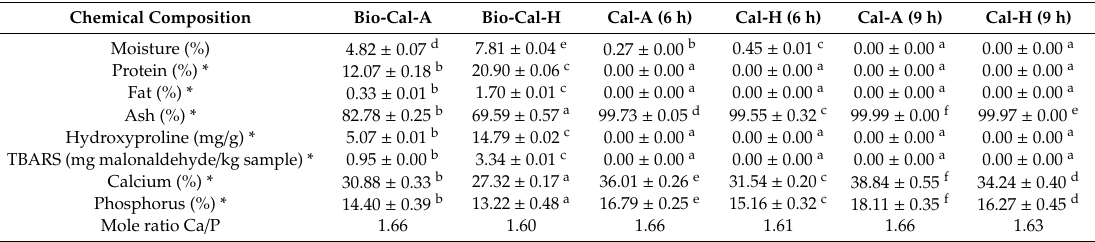
Table 1. Chemical composition of bio-calcium and calcined powders from salmon frame. Chemical